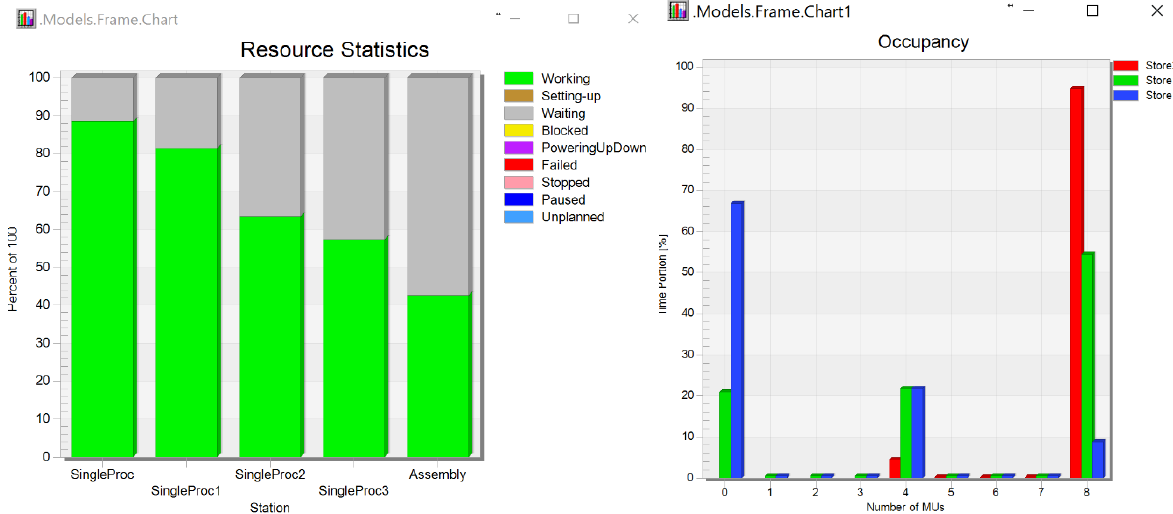
Figure 6: Example of information about simulated process obtained from special blocks.